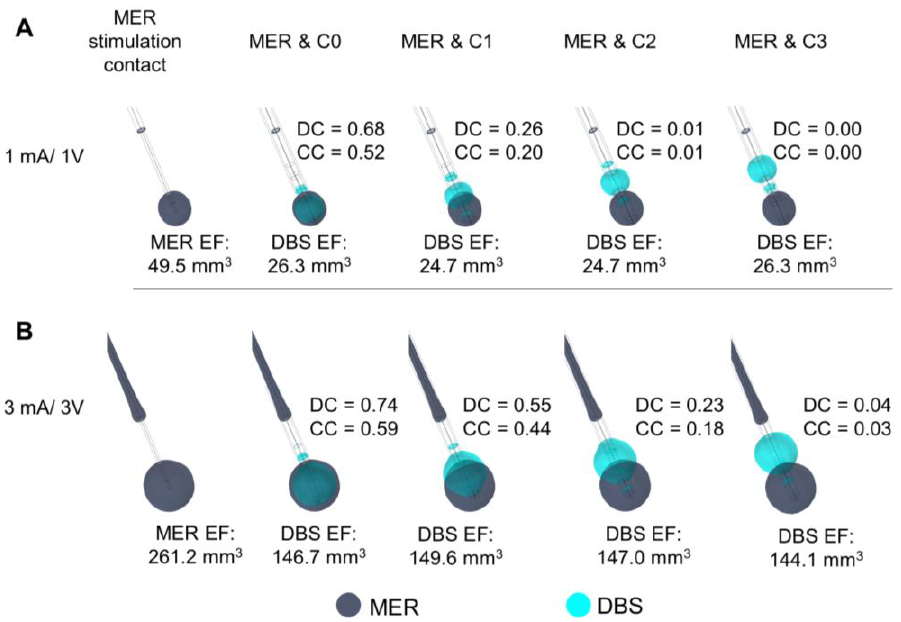
Figure 5. Comparison of the EF between the MER stimulation contact and each DBS contact simulated in a heterogeneous medium (σ ≈ 0.079 S/m). DBS first contact (C0) (cyan) aligned to match the middle point of the MER stimulation contact (dark blue). EF isosurfaces (0.2 V/mm) superimposed for ( A ) MER stimulation contact set to 1 mA and the active DBS contact set to 1 V, and ( B ) for 3 mA and 3 V. EF volume within the selected isosurface shown below the lead and Dice coefficient (DC) and coverage coefficient (CC) shown to the right of each lead.